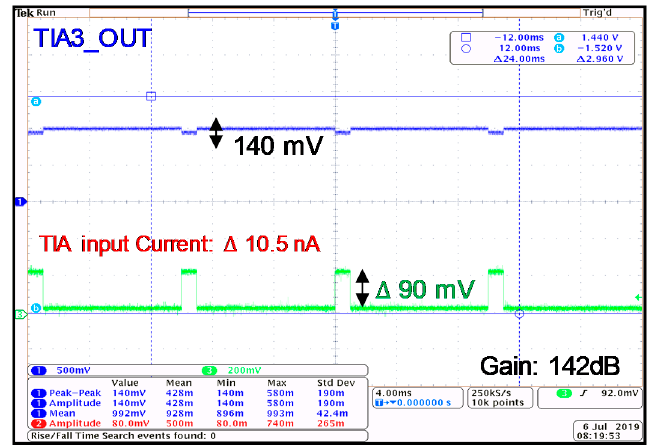
Figure 15. The measured maximum gain for the TIA.